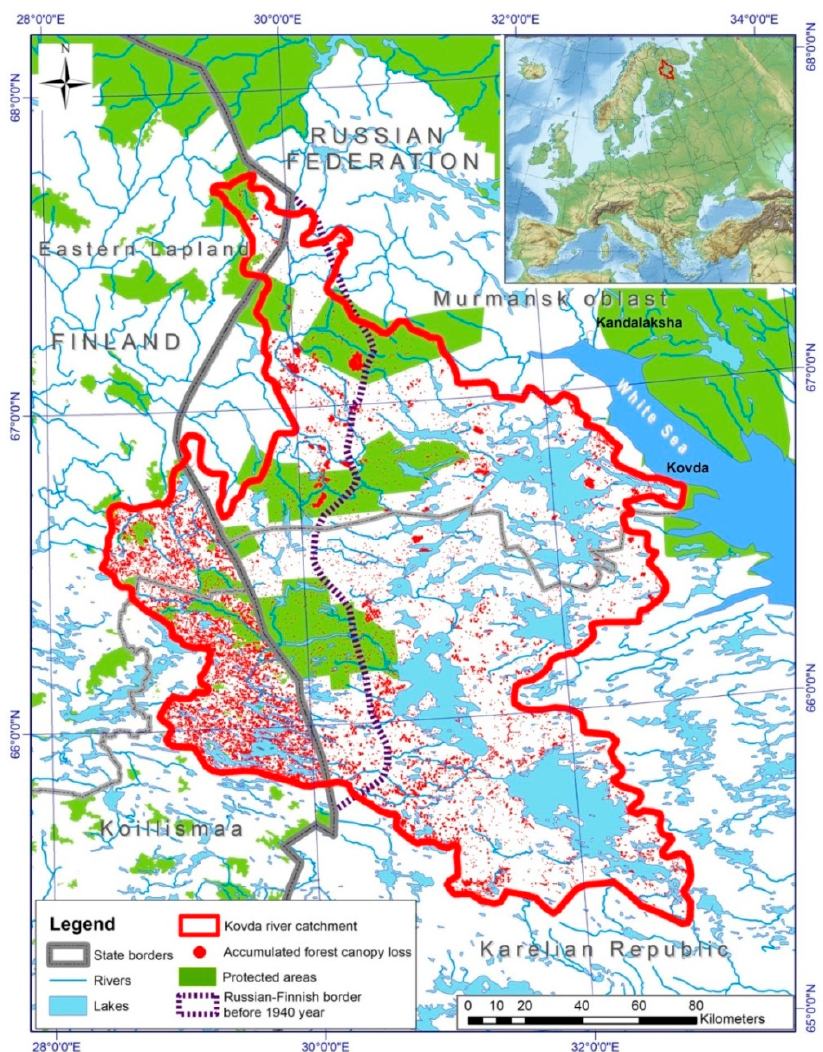
Figure 1. Map of the Kovda River catchment located around the Arctic Circle (66°33 ′ N) in north-eastern Finland, and in Russia’s Murmansk oblast and the Republic of Karelia. The current Finnish-Russian border is located further west than the pre-1940 border. The Kovdozersky forest management unit lies in the northeastern part of the catchment where the Kovda River enters the White Sea south of Kandalaksha. The Paanajärvi National Park, also part of a large intact forest landscape, is shown as the transboundary protected area on the map. The red dots show the location of forest canopy loss 2001–2018 derived through Potapov et al. [50] and Hansen et al. [60] methodology) within the Kovda River catchment. Note that the protected area borders are generalised.